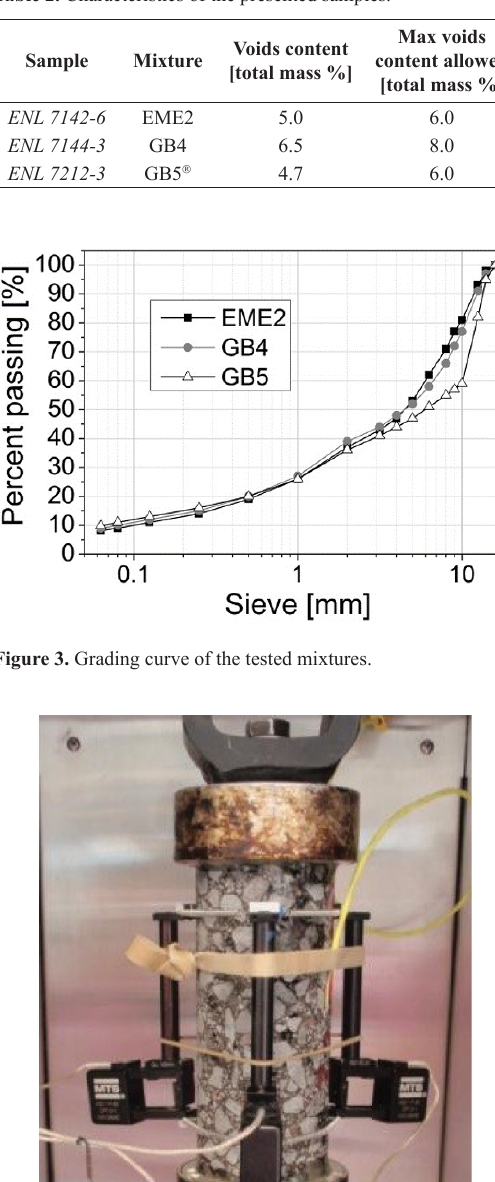
Table 2. Characteristics of the presented samples.